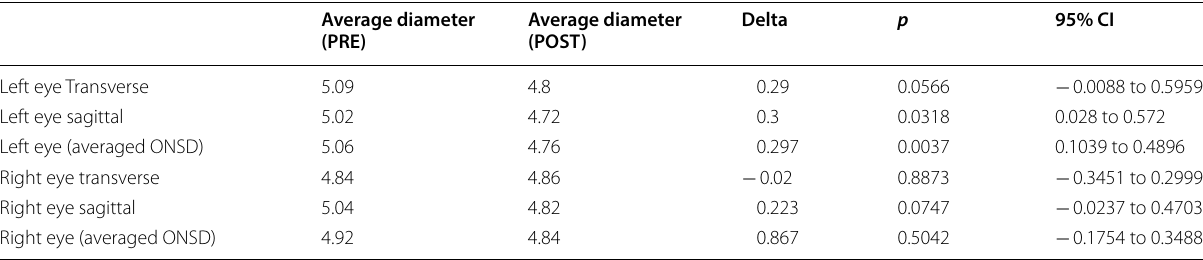
Table 2 Comparison of participant optic nerve sheath diameter, by plane of measurement, pre-lumbar puncture compared to post-lumbar puncture for all participants